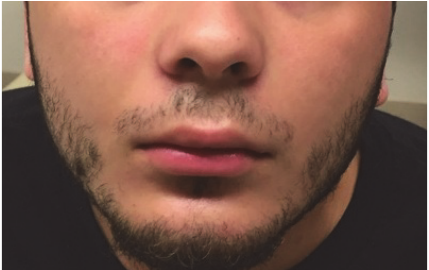
Figure 2: Patient attempting to smile with loss of cranial nerve VII bilaterally.